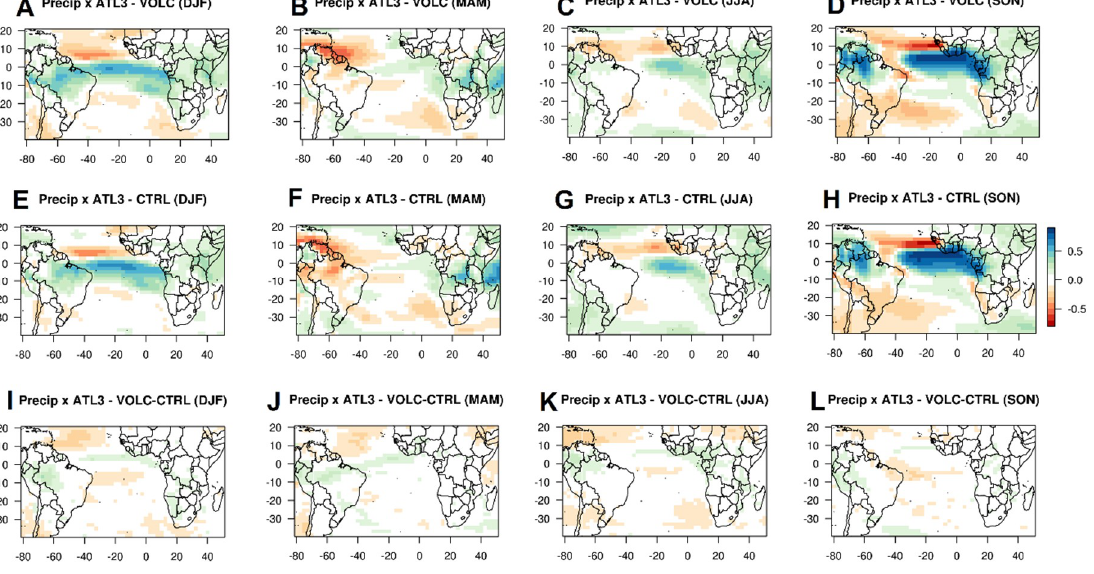
Figure 9. Seasonal correlation between precipitation and ATL3 SST index (at 95% significance level). Vertical: seasonal correlation (December to February – DJF; March to May – MAM; June to August – JJA; and September to November – SON). Horizontal: VOLC ensemble mean ( A – D ), CTRL simulation ( E – H ), and difference between VOLC and CTRL ( I – L ). Only statistically significant values are shown.